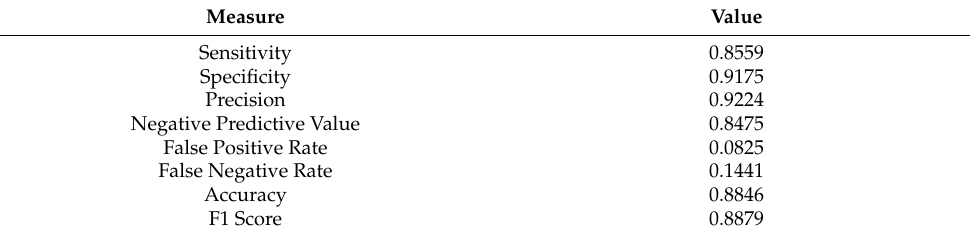
Table 8. ANN Confusion Matrix Measure